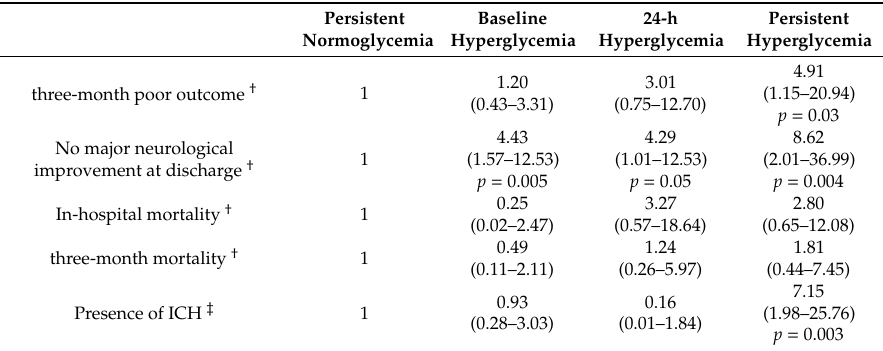
Table 4. Logistic regression model in non-diabetic patients: adjusted ORs (95% CIs) of hyperglycemic patterns in relation to the respective